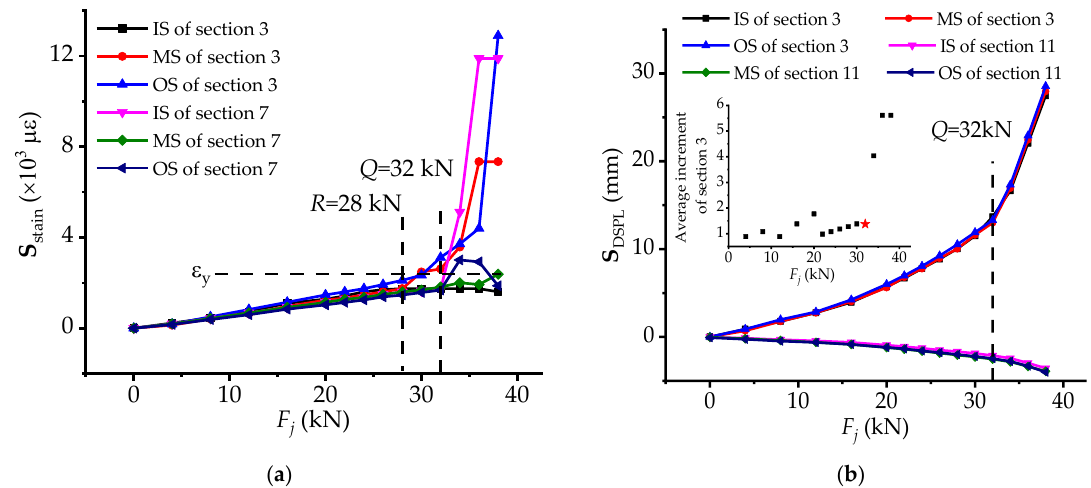
Figure 7. The curves of strain-based and DSPL-based stressing state modes with respect to load for bridge girder: ( a ) The S strain - F curve for sections 3 and 7; and ( b ) The S DSPL - F curve for sections 3 and 11.